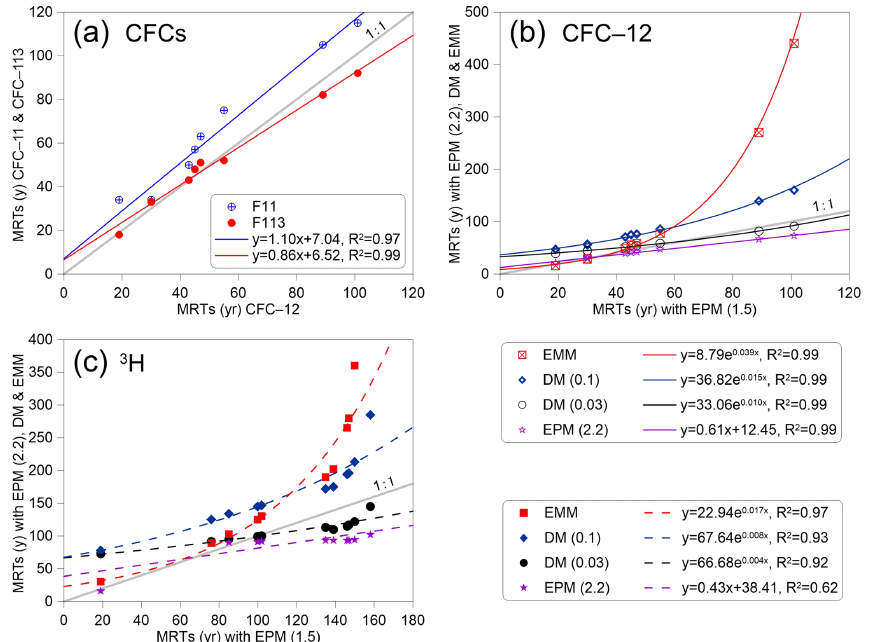
Figure 11. (a) Mean residence times (MRTs) for CFC-12 vs. MRTs for CFC-11 and CFC-113 data using the EPM (1.5) model. (b) MRTs for CFC-12 with EPM (1.5) vs. those with other models. (c) MRTs for 3 H vs. those with other